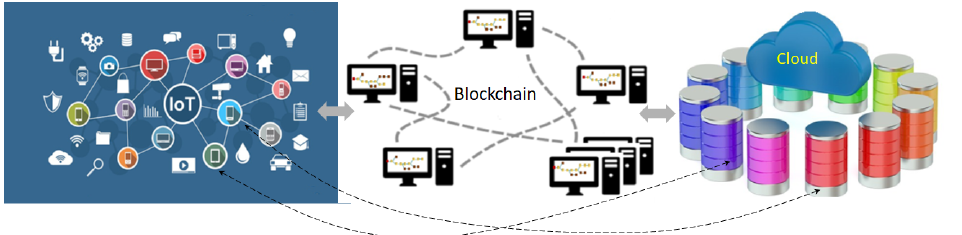
Figure 1. Network architecture for blockchain-based